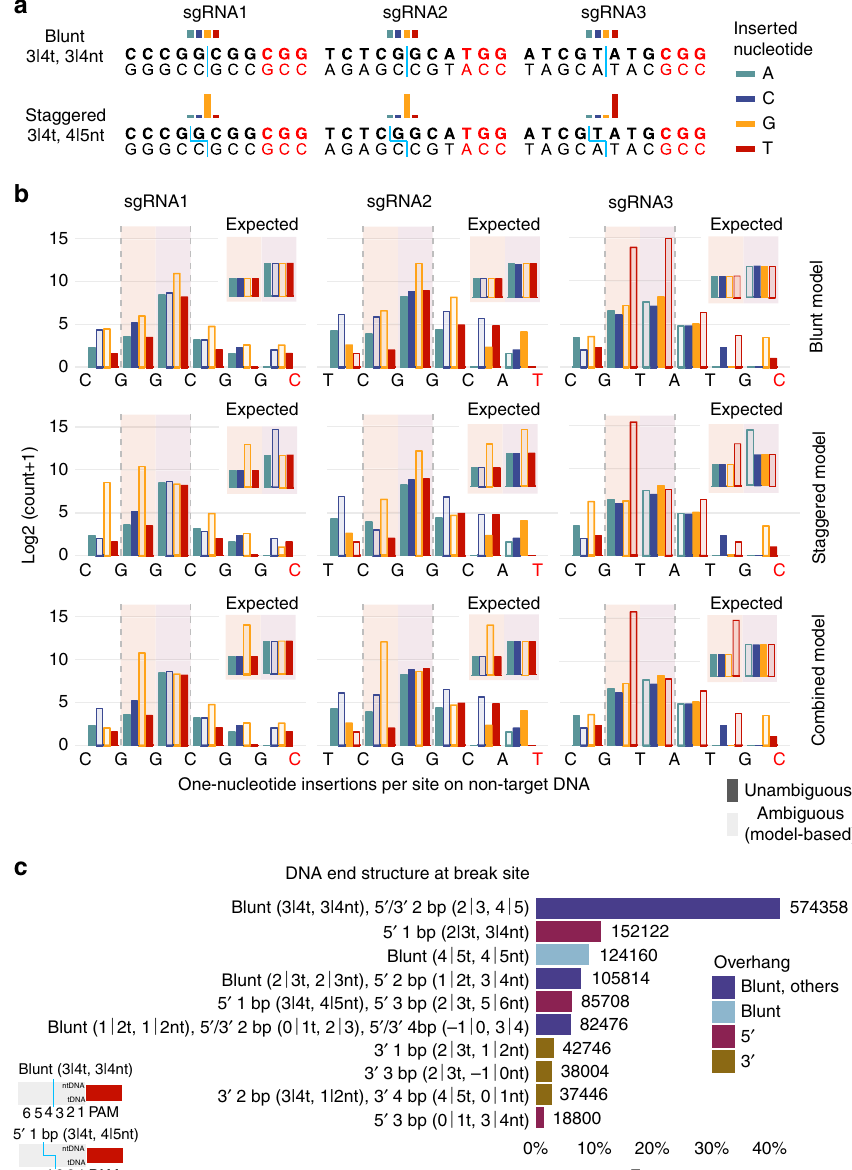
Fig. 5 One-nucleotide insertion patterns and DNA end structures at the break site. a Illustration of blunt and staggered DNA ends at the break site, and expected distribution of 1-bp insertions of the four nucleotides following DNA repair. Double-stranded sequences including PAM and 8-bp upstream, with bottom and top denoting target and non-target DNA. Blue straight and staggered lines through the sequences indicate blunt and staggered DNA ends. Colored bars on top sketch the expected distribution of 1-bp insertions upon DNA repair. Blunt model: blunt-ends primarily at 3|4 upstream of the PAM (straight line), resulting in template-independent insertion and thus similar frequencies of the four nucleotides (uniform distribution, similar-height colored bars). Staggered model: staggered ends mostly with termini at 3|4 (tDNA) and 4|5 (ntDNA) upstream of the PAM (staggered line), with template- dependent fi ll-in resulting in a skewed distribution with most insertions of the DNA base identical to nucleotide 4 (unequal-height colored bars). b Unambiguous insertion counts ( fi lled bars) and ambiguous insertion counts (empty bars) redistributed according to blunt, staggered, and combined models. Shown are insertion counts (vertical axis) of each nucleotide (color) per site on the ntDNA (horizontal axis). Vertical shaded areas indicate the 3|4 and 4|5 sites upstream of the PAM. Unambiguous counts are directly determined from the data ( fi lled bars), whereas ambiguous counts are redistributed over windows of ambiguous sites (empty bars) based on: (i) relative proportions of unambiguous counts, and (ii) likelihood of each nucleotide insertion according to the cleavage model. ( c ) Re-analysis of DNA ends generated by Cas9 targeting of a region on chromosome 6 in mouse pre-B cells de fi cient in DNA Ligase IV and arrested in G1 phase. Bar length denotes relative frequency, shown for the ten most frequent DNA end structures accounting for ~ 91% of all unique patterns in the data. Absolute frequencies are displayed. Multiple DNA end structures associated with the same sequence are grouped with a single bar and label. Bars are colored by type of structure. The bottom left fi gure shows an illustration of two DNA structures: blunt (3|4t, 3|4nt), and 5´ 1-bp overhang (3|4t, 4|5nt). Source data are provided in the Source Data fi